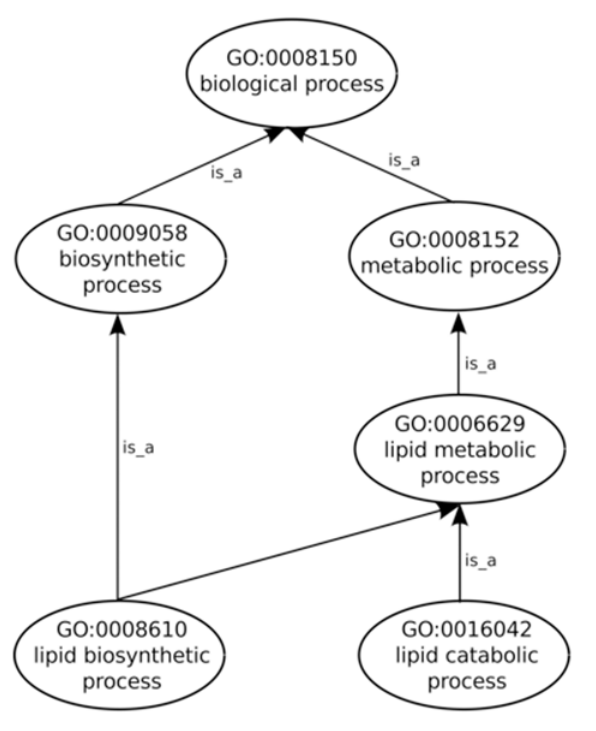
Fig 1. GO graph. Sub-graph of the GO biological process sub-ontology depicting is_a relationships.